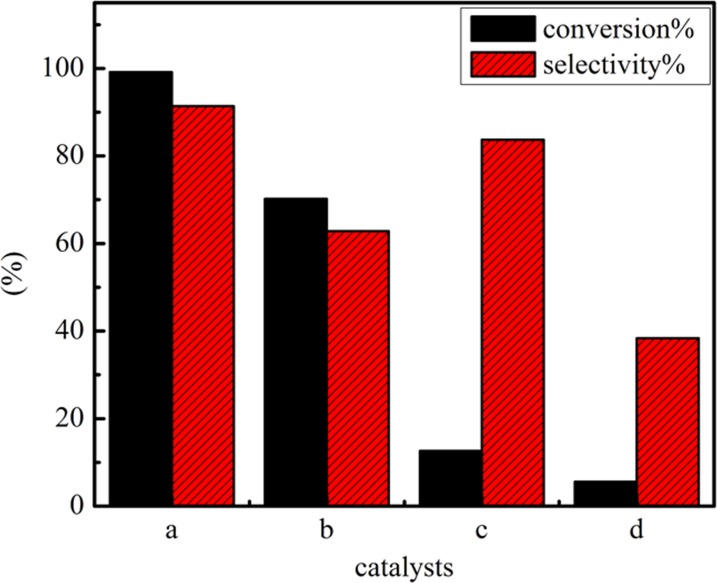
Effect on the catalytic performance of the three catalysts in the epoxidation of cyclohexene: (a) Ag-TiO2-SiO2; (b)Ag; (c) TiO2-SiO2; (d)blank (Reaction conditions: catalyst, 80 mg; cyclohexene, 6 mL; H2O2, 6 mL; chloroform, 12 mL; for 120 min).